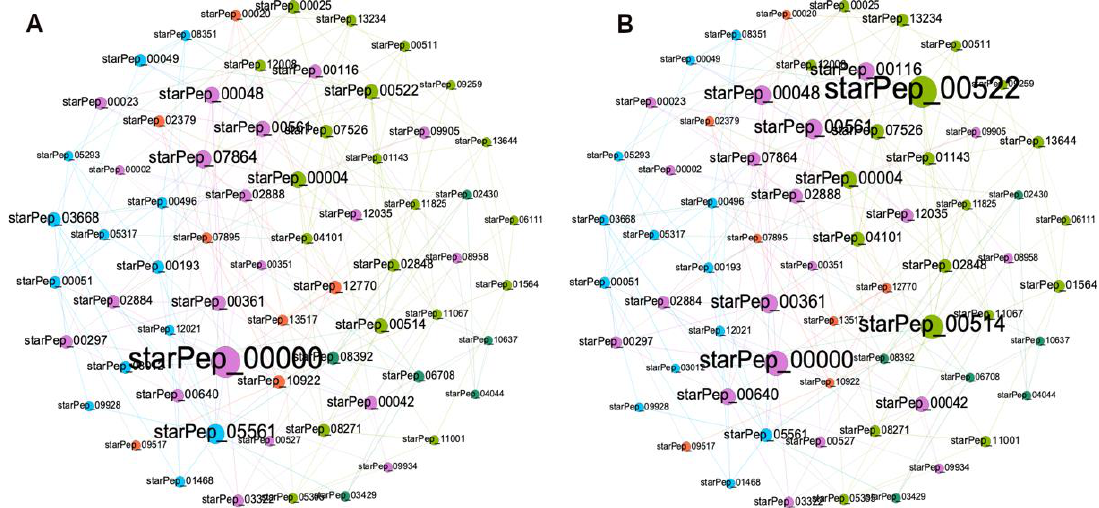
Figure 7. HSPNs visualization of the representative subset integrated by 66 ABFPs from the HC ∪ HB of the subset 7 (cutoff 0.40) using the Fruchterman-Reingold layout. Peptides communities are represented by different colors while the nodes size was scaled according to harmonic ( A ) and hub-bridge centrality ( B )